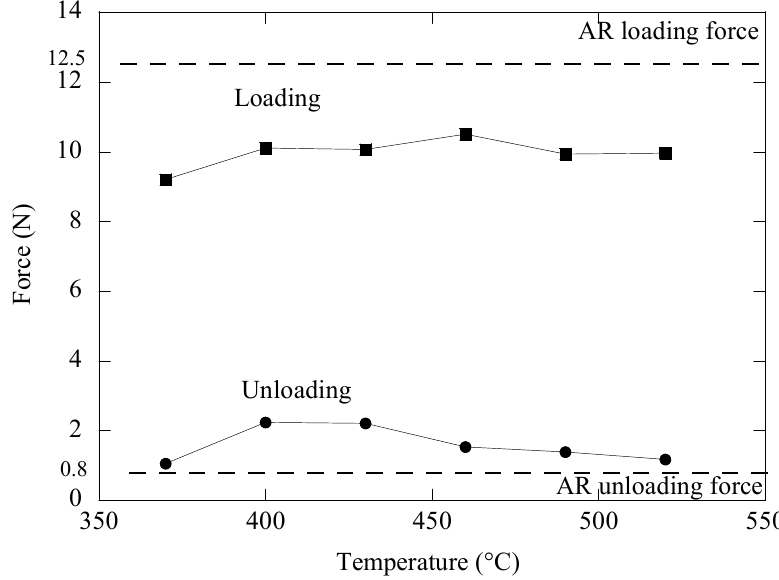
Figure 5. Variation in loading and unloading forces of aged NiTi archwires obtained from the modified three-bracket bending test.